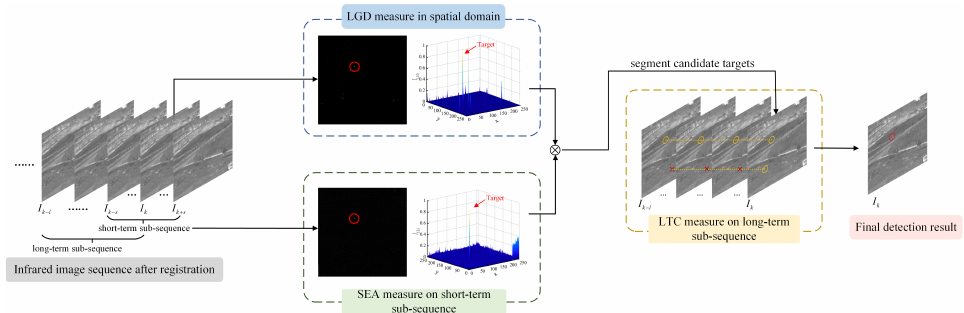
Figure 1. Flow chart of the proposed STFM method. Here, I k denotes the k th frame in the image sequence. The short-term sub-sequence contains ( 2 s + 1 ) frames and the long-term sub-sequence contains l frames ( l > s ) . The candidate targets and the real target are marked using yellow circles and a red circle, respectively, and the red multiplication sign means that the candidate targets in adjacent frames are matched